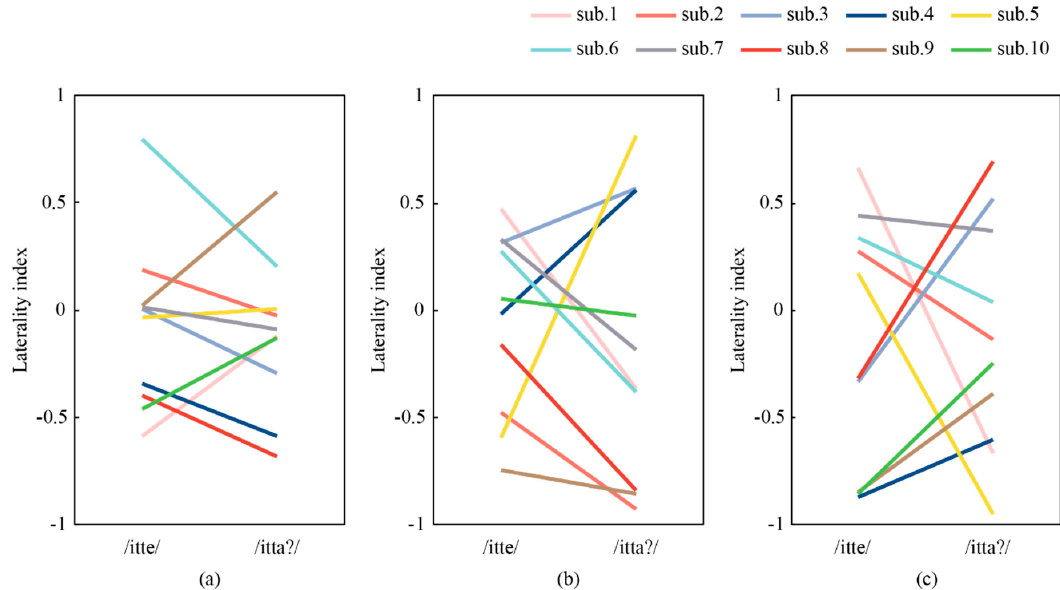
Figure 13. Laterality index (LI) of ( a ) NIRS, ( b ) MMN, and ( c ) P300 for each participant. Six of 10 participants showed greater LI for /itte/ than for /itta?/ as previously reported. Laterality was not 10 participants showed greater LI for / itte / than for / itta? / as previously reported. Laterality was not captured with EEG. captured with